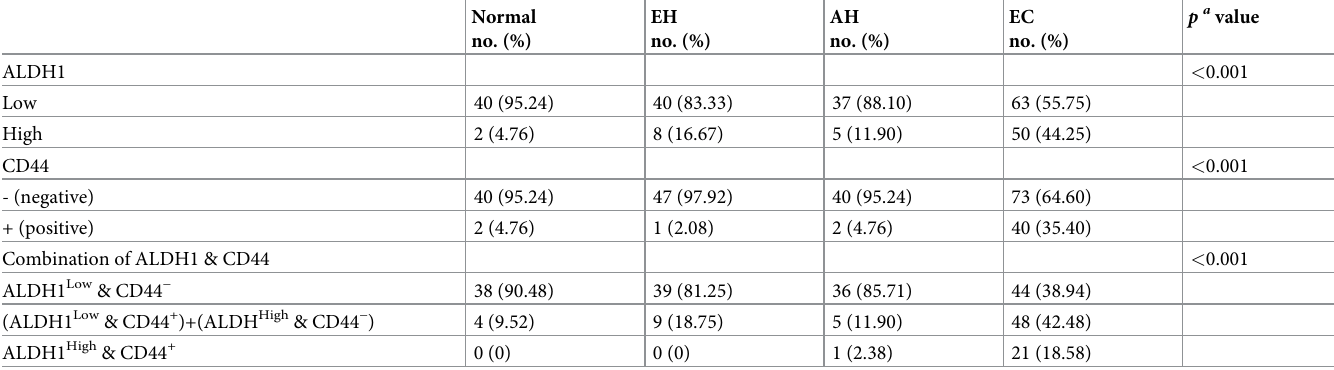
Table 1. Chi-square test results for ALDH1 and CD44 expression score based on the staining area and intensity of color reaction.